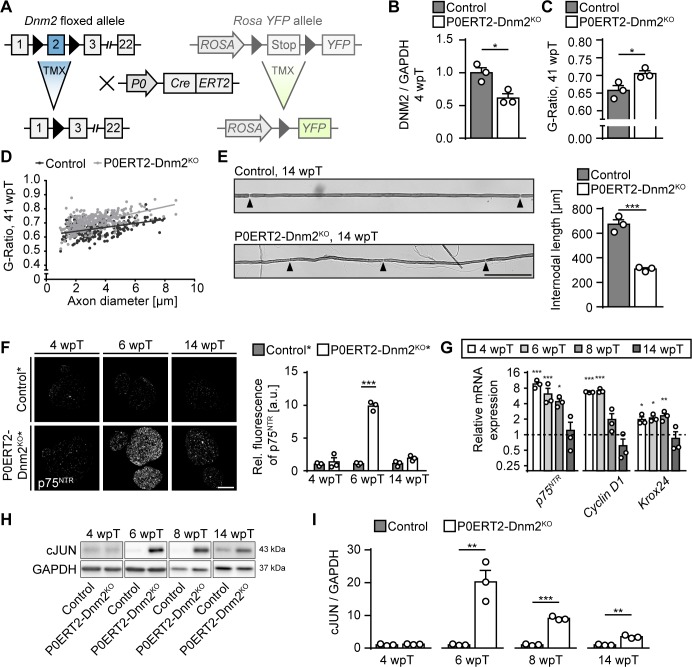
Dynamin 2 ablation in adult Schwann cells induces transient cellular dedifferentiation.(A) Schematic representation of inducible Dnm2 ablation and YFP expression in adult SCs. The inducible Cre-ERT2 fusion recombinase is expressed under the SC-specific Myelin Protein Zero (Mpz) promoter. Upon tamoxifen injection, the recombinase shuttles into the nucleus leading to excision of floxed exon 2. The Cre-dependent RosaYFP-reporter allele was used in some experiments to track recombination in SCs. In this case, the transcription stop signal flanked by loxP sites is excised upon tamoxifen administration leading to YFP expression. (B) Quantification referring to Figure 2A, full-length blots in Supplementary file 1B. Relative amounts of DNM2 protein in sciatic nerve (SN) extracts derived from Dnm2loxP/loxP (control) and MpzCreERT2:Dnm2loxP/loxP (P0ERT2-Dnm2KO) mice at 4 wpT. Control average was set to 1. N = 3 mice/genotype, two-tailed unpaired Student’s t-test. (C) Average g-ratios of control and P0ERT2-Dnm2KO SNs indicate a slight hypomyelination of mutant mice at 41 wpT. At least 90 axons/sample were analyzed (random EM fields). N = 3 mice/genotype, two-tailed unpaired Student´s t-test. (D) G-ratios as function of axon diameters. (E) (left) Exemplary picture of internodes of teased osmicated fibers from SNs of control and P0ERT2-Dnm2KO mice at 14 wpT. (right) Quantification of internodal lengths. 100 internodes/animal were measured, n = 3 mice/genotype, two-tailed unpaired Student´s t-test. Black arrowheads: Nodes of Ranvier. Scale bar = 100 μm (for both panels). (F) (left) Immunostaining of MpzCreERT2:Rosa26-stoploxP/loxP-YFP (control*) and MpzCreERT2:Dnm2loxP/loxP:Rosa26-stoploxP/loxP-YFP (P0ERT2-Dnm2KO*) SN cross-sections for p75NTR at different time points. There was a pronounced, but transient increase of p75NTR staining at 6 wpT in P0ERT2-Dnm2KO* mice. (right) Quantification of relative signal intensity of p75NTR immunostaining/SN cross-section. N = 3 mice/genotype, Two-Way ANOVA with Sidak’s multiple comparisons test. Scale bar = 200 μm. (G) qRT-PCR of P75NTR, cyclinD1 and Krox24 from control and P0ERT2-Dnm2KO SNs at the indicated time points. Transcript levels were normalized to GAPDH. Control values were set to one for each individual transcript at each time point. N = 3 mice/genotype, Two-Way ANOVA with Sidak’s multiple comparisons test. (H) Exemplary picture of immunoblot analysis of cJUN in SN extracts from control and P0ERT-Dnm2KO mice at the indicated time points. N = 3 mice/genotype. Full-length blots in Supplementary file 1E. (I) Quantification referring to Figure 2H, Supplementary file 1E. Control average was set to one for each time point individually. N = 3 mice/genotype, two-tailed unpaired Student’s t-test. Results in graphs represent means ±s.e.m.; *p<0.05, **p<0.01, ***p<0.001.